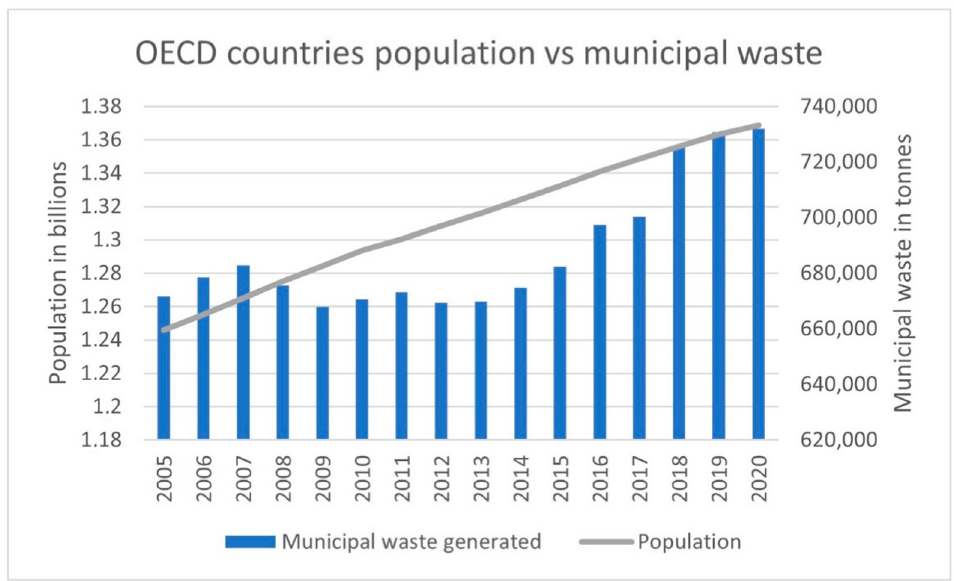
Figure 1. The annual population growth recorded in OECD countries vs. municipal waste is reflected in the graph (Data from OECD [27]).